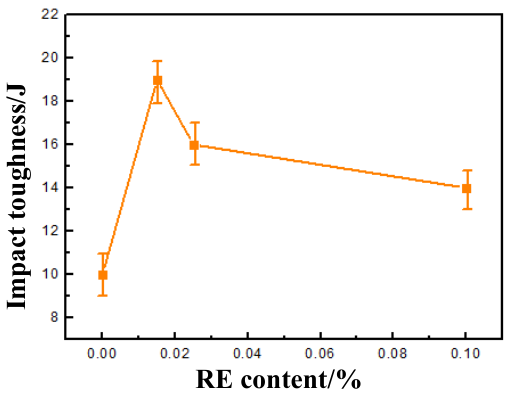
Figure 8. The impact toughness of H13